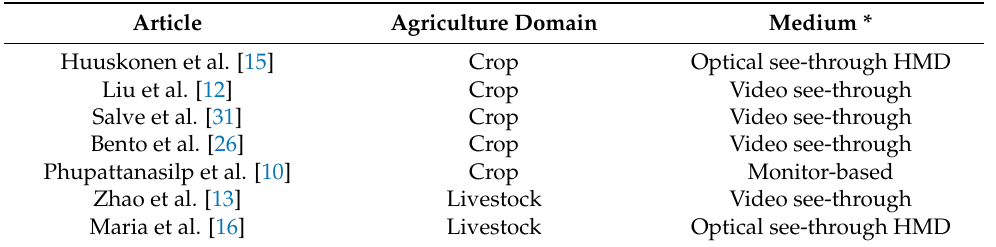
Table 2. AR Hardware Approaches